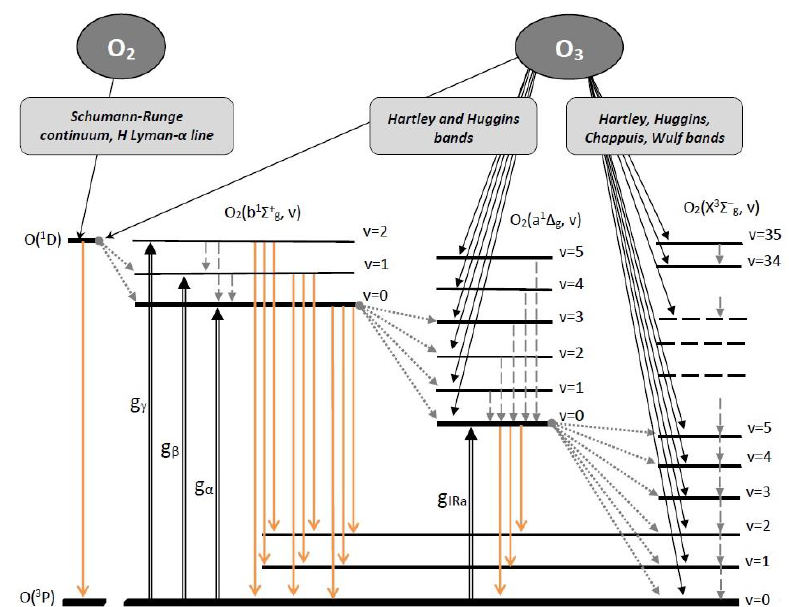
Figure 12. The scheme of electronic–vibrational kinetics of the products of O 2 and O 3 photolysis in the MLT region (YM2011 model, version 2019), taking into account 9 excited levels of the oxygen molecule (three levels О 2 (b 1 Σ +g , v = 0, 1, 2), six levels O 2 (a 1 Δ g , v = 0–5)), 35 levels O 2 (X 3 Σ −g , v = 1–35) and, also, the excited level of the oxygen atom, O( 1 D). Solid thin lines with arrows designate the processes of O 2 and O 3 photolysis. Double vertical lines with arrows designate the processes of solar radiation resonance absorption in the 762 nm (g α ), 688 nm (g β ), 629 nm (g γ ) and in the 1.27 µm (g IRa ) bands. Short dashed inclined lines with arrows present energy transfer from O( 1 D) to the O 2 (b 1 Σ +g , v = 0, 1), from O 2 (b 1 Σ +g , v = 0) to O 2 (a 1 Δ g , v = 0–3) and from O 2 (a 1 Δ g , v = 0) to O 2 (X 3 Σ ¯g , v = 0–5) at collisional quenching. Long dashed vertical lines with arrows denote collisional V–V transitions. Solid orange vertical lines with arrows pointed down designate the processes of emissions from electronic–vibrational levels of O 2 molecule and from excited atom O( 1 D).